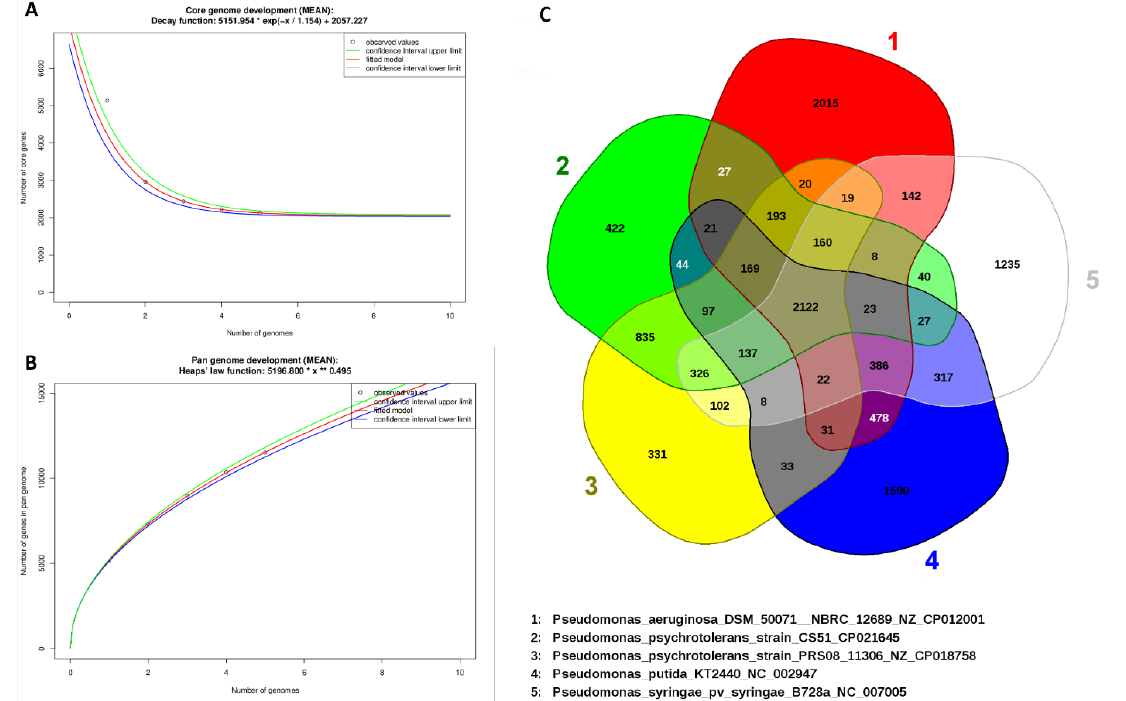
Figure 6. ( A ) The number of gene clusters in the core genome, ( B ) the number of gene clusters in the pan-genome was plotted against the number of Pseudomonas species genomes, and ( C ) Venn diagram illustrating the orthologous gene complements of P. psychrotolerans CS51, P. aeruginosa , P. psychrotolerans PRS08 , P. putida , and P. syringae. The number in the center represents orthologous sequences common to all five genomes, whereas the unique genes identified in the genomes are in the outer circles.